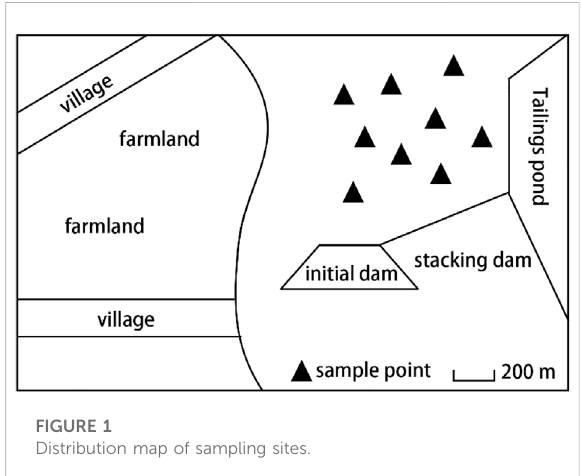
FIGURE 1 Distribution map of sampling